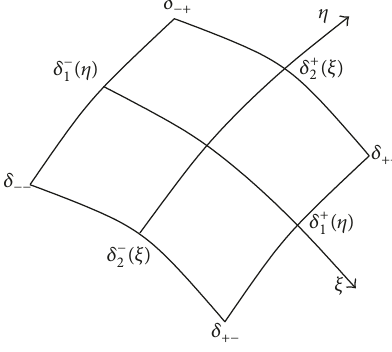
Figure 30: The function 𝛿(𝜉, 𝜂)